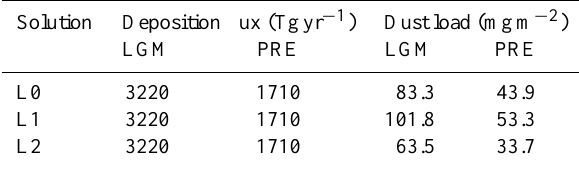
Table 2. Global dust deposition flux and dust load per area from three solutions of climate system model simulated at 21ka (LGM) and 0ka